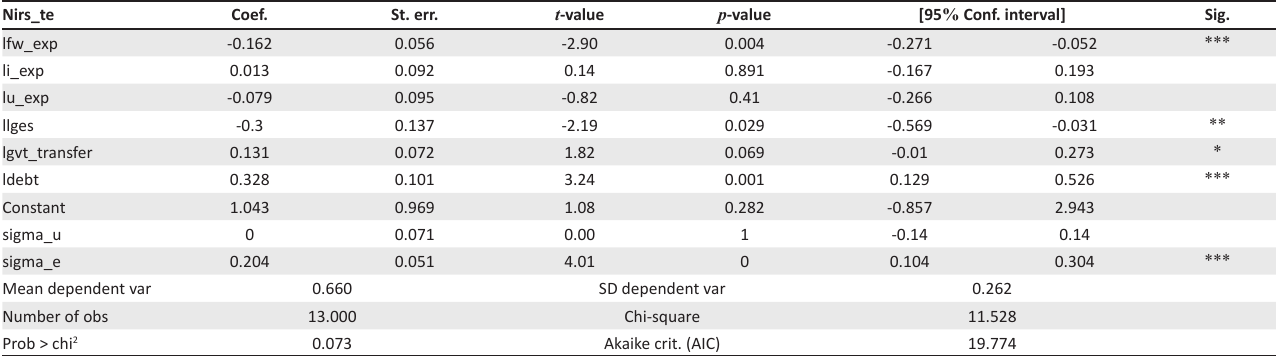
TABLE 3-A1: Random-effects tobit